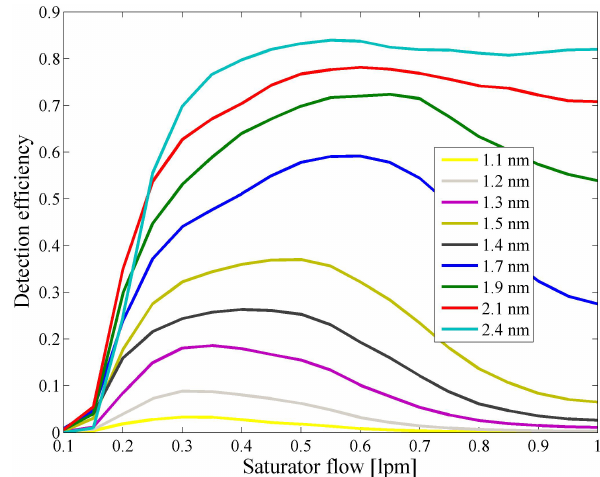
Figure 6. The detection efficiency of the nCNC as a function of the mobility diameter for negatively charged tungsten oxide particles at pressures of 60, 80 and 100kPa.